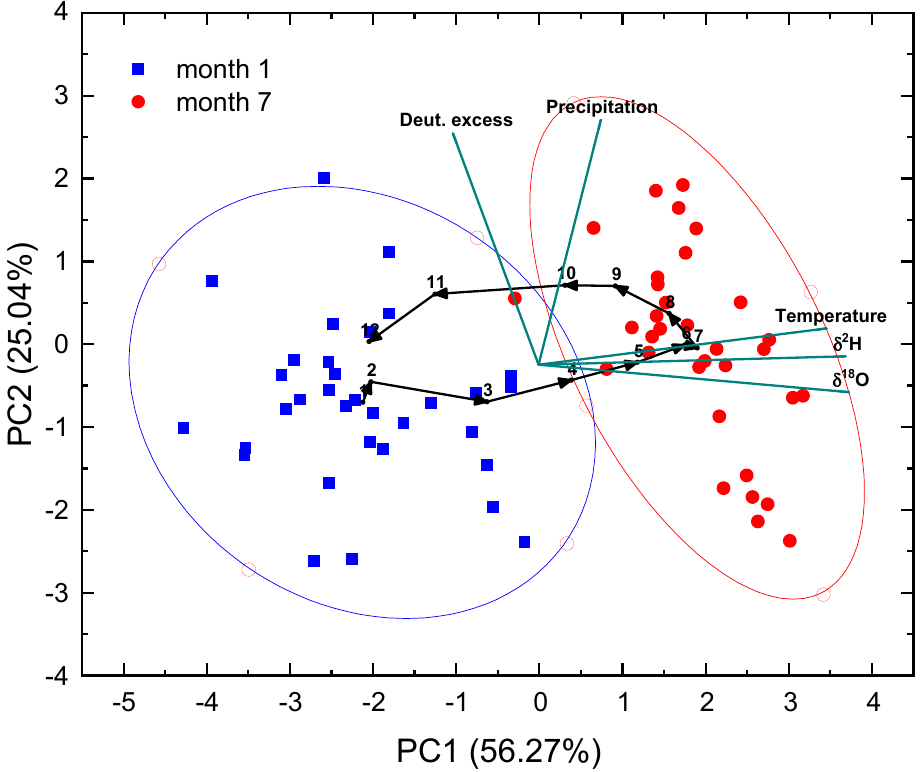
Figure 1. PCA of month 1 (blue squares) and month 7 (red dots); black dots connected with arrows represent each month in the year.